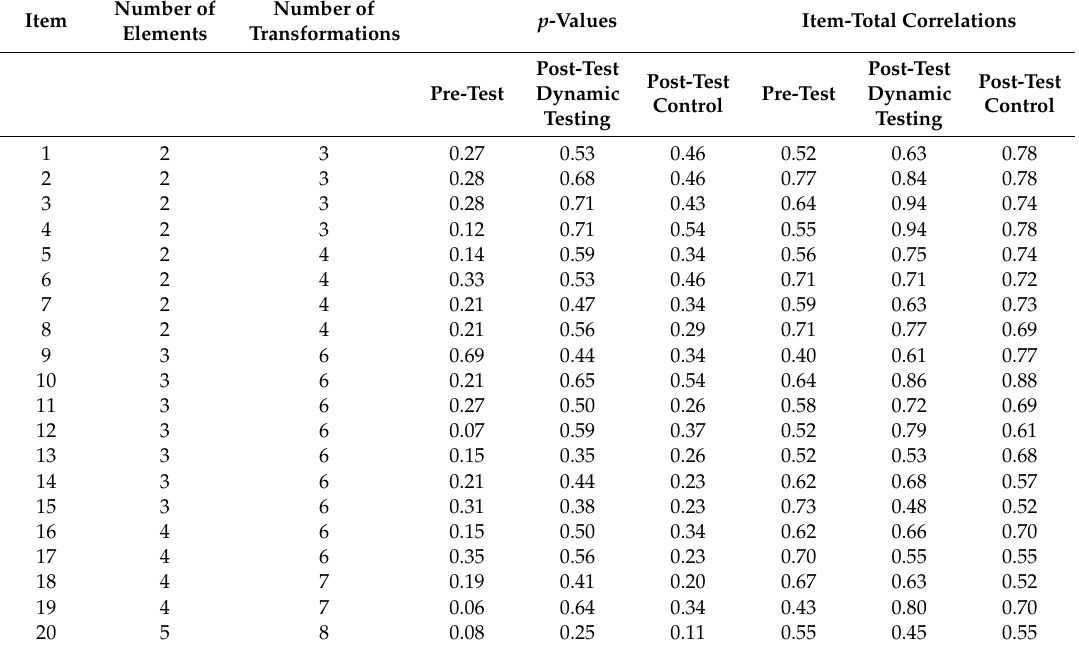
Table A2. Psychometric characteristics of the pre-test and post-test in terms of the number of elements and transformations per item number, the corresponding p -values and the item-total correlations.